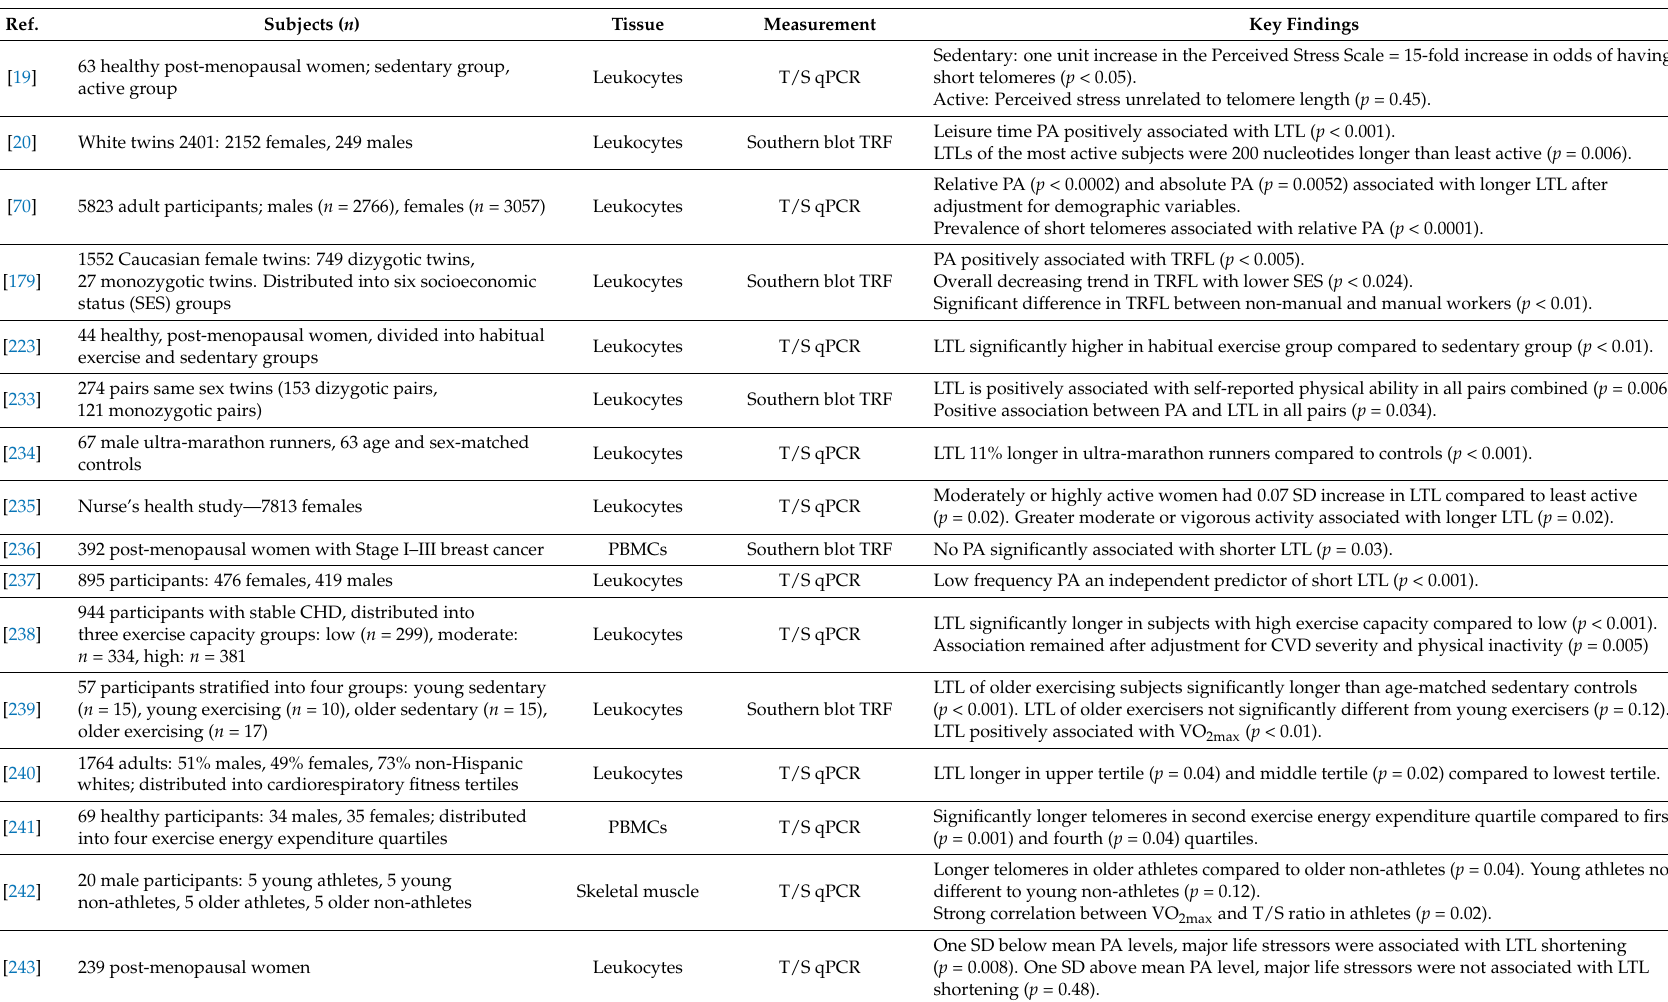
Table 1. A summary of studies showing positive associations between physical activity and telomere